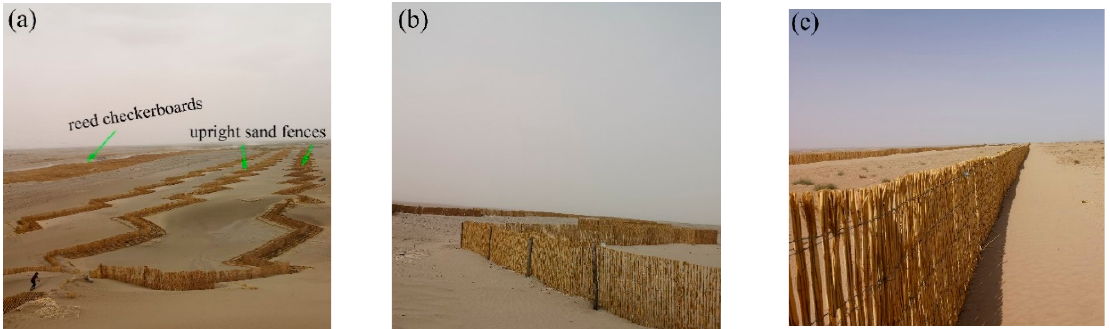
Figure 11. Mechanical sand prevention system and its specific patterns: ( a ) overall layout; ( b ) folded sand barriers; ( c ) straight sand barriers.